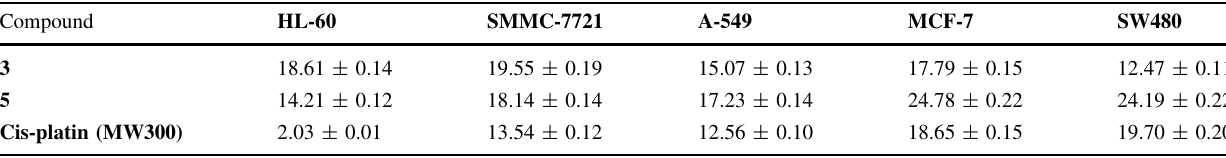
Table 2 Cytotoxicity of compounds 3 and 5 (IC 50 : l M)